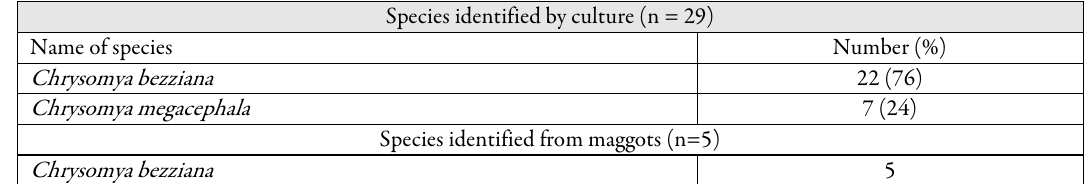
Table 3. Species causing